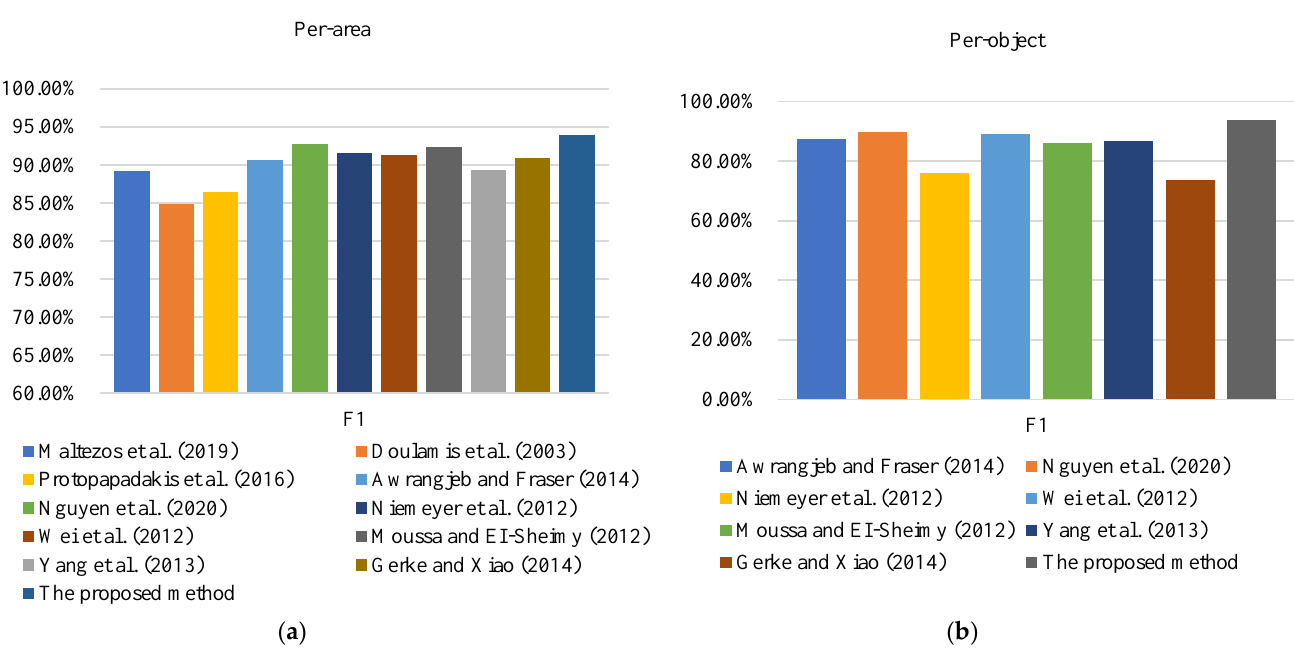
Figure 6. Average quality comparison between the proposed method and ten other methods. ( a ) Per-area level; ( b ) per- object level. The average qualities of the ten methods are obtained from the corresponding references. The methods pro- posed by Maltezos et al. (2019), Doulamis et al. (2003) and Protopapadakis et al. (2016) do not provide the quality at per- object level.